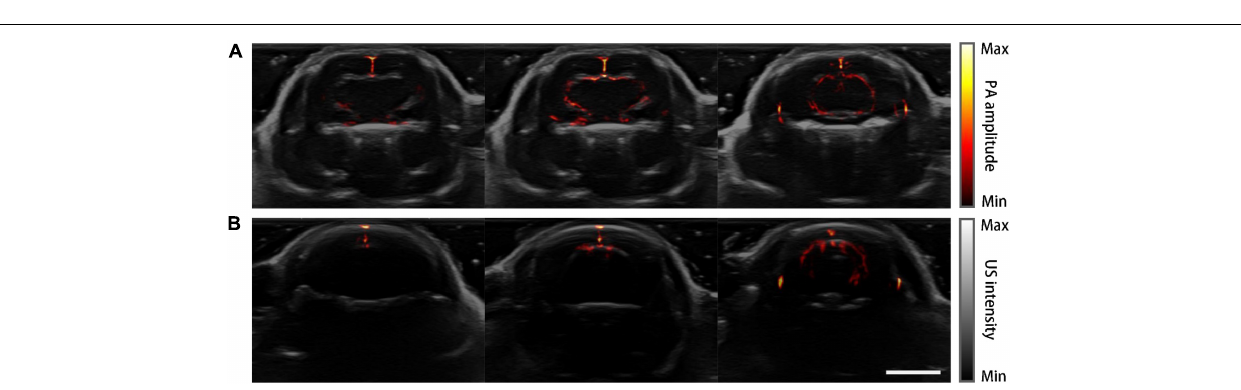
FIGURE 6 | PA-US dual-modality imaging results. PA images are in pseudo-color and the US images are in grayscale as background. (A) PA-US images of the mouse model acquired at three coronal planes. (B) PA-US images of the normal mouse in the same planes of (A) . Scale bar = 5